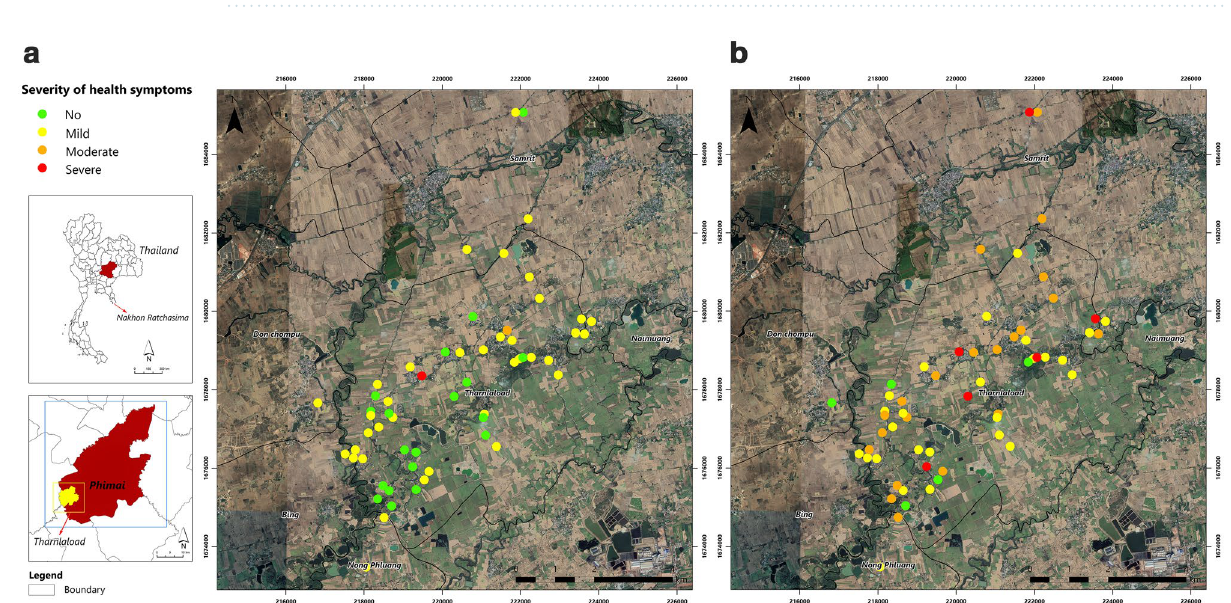
Figure 3. Severity of health symptoms among farmers presented on the GIS maps during both study periods. Figure was created by the ArcGIS version 10.8 software (Environmental Systems Research Institute, Inc,